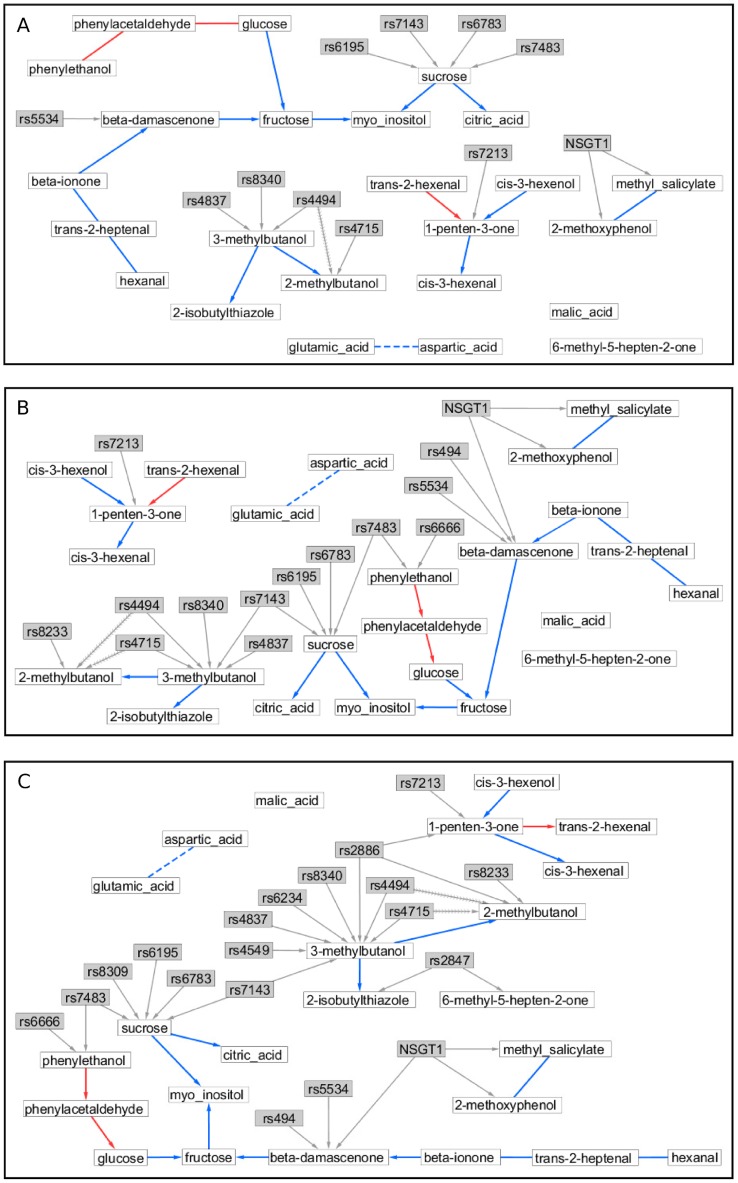
Three partially directed graphs describing the relationships among 24 metabolites in ripe tomato fruits.Clear nodes represent metabolites; shaded nodes denote QTLs identified for the metabolites. QTLs in (A), (B) and (C) were selected on the basis of –log10 (p-value) thresholds 5.5, 5.0 and 4.5, respectively. Grey edges link QTLs to the corresponding metabolites. Blue and red edges, without regard to their directions, were learnt by the PC-skeleton algorithm; their directions, if any, were inferred by the QPSO algorithm. Blue edges occur consistently throughout the three graphs representing different test levels for QTLs, while red edges do not. Solid and dashed edges indicate positive and negative correlations, respectively; fishbone edges are removed by post hoc causal reasoning.